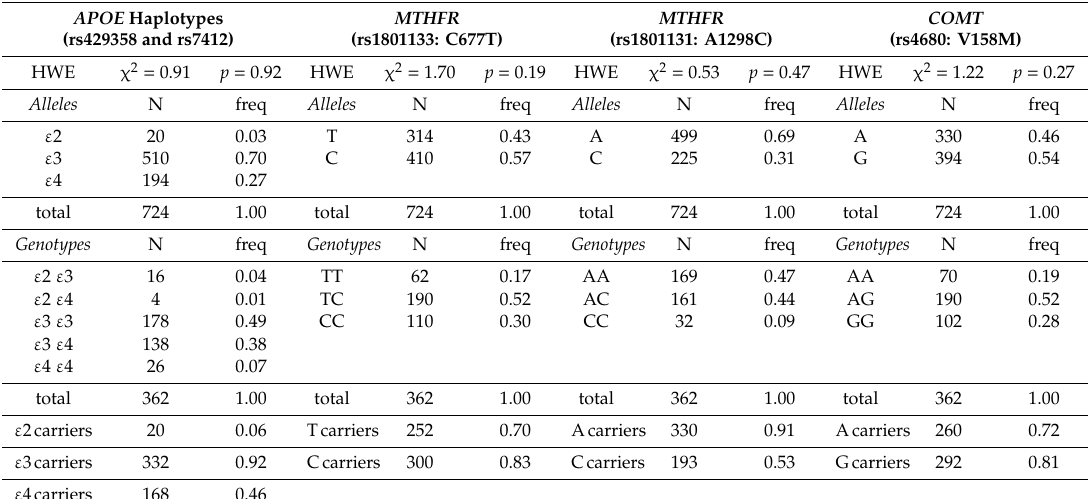
Table 2. Genetic distribution of our Alzheimer’s Disease Italian cohort for APOE , MTHFR , and COMT genes polymorphisms. APOE Haplotypes (rs429358 and